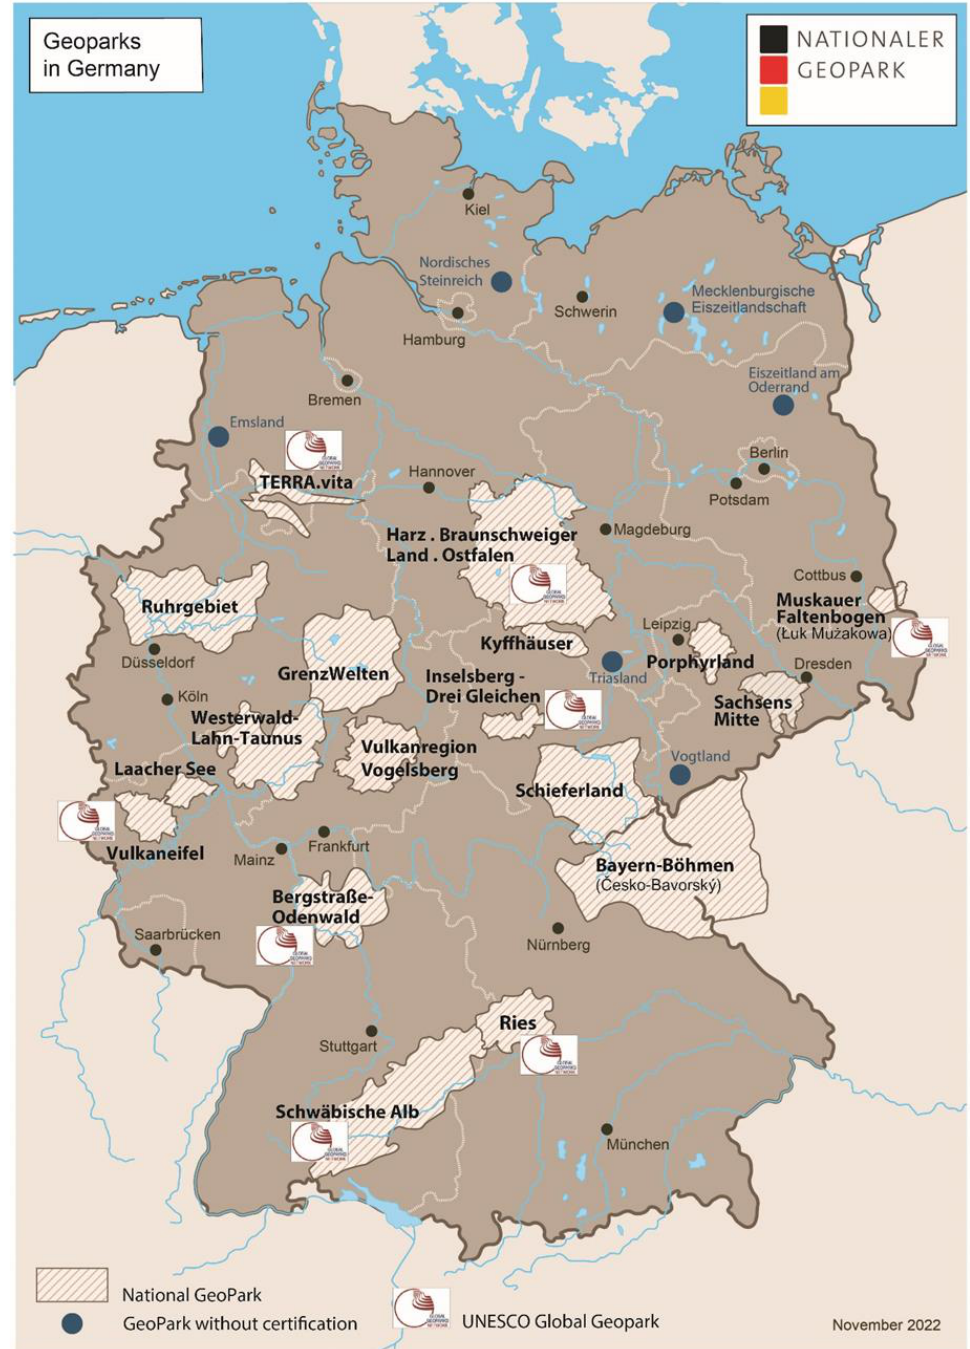
Figure 2. Geoparks in Germany (Source: Geo-Union Alfred Wegener Stiftung).